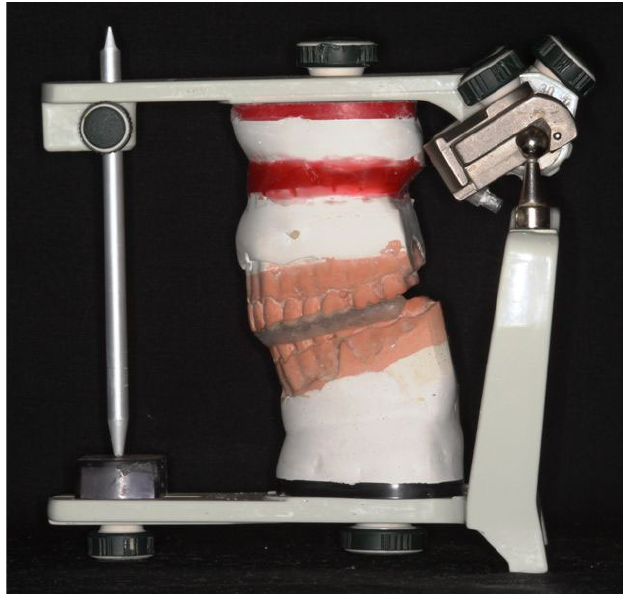
Fig. 5. Lateral view of the maxillary model advancement of 8 millimeters and mandible model with the intermediate splint made from acrylic